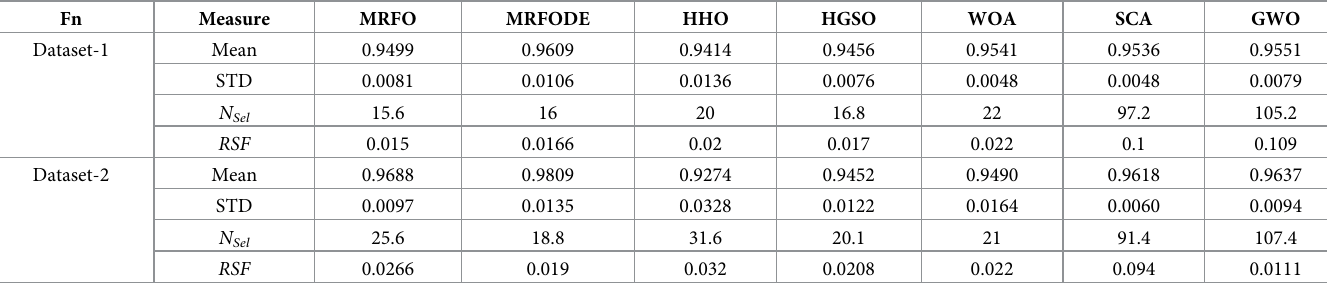
Table 2. Comparison results of MRFODE and other MH methods in terms of accuracy.